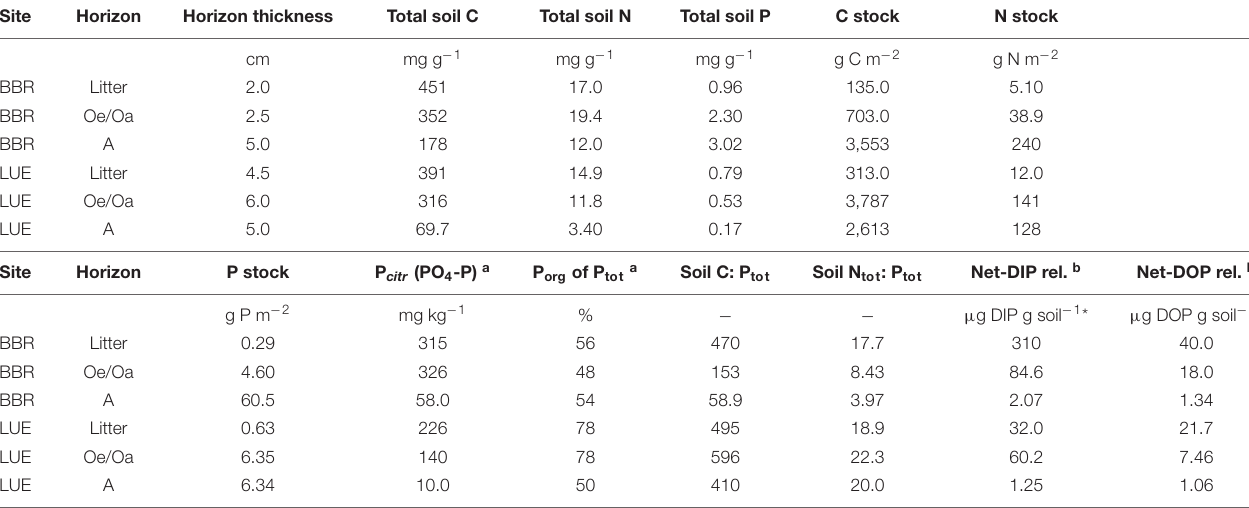
TABLE 2 | Phosphorus (P), carbon (C), and nitrogen (N) forms from the non-fertilized litter layer, Oe/Oa horizon, and A horizon of the two study sites Bad Brückenau (BBR, P-rich) and Lüss (LUE, P-poor). Site Horizon Horizon thickness Total soil